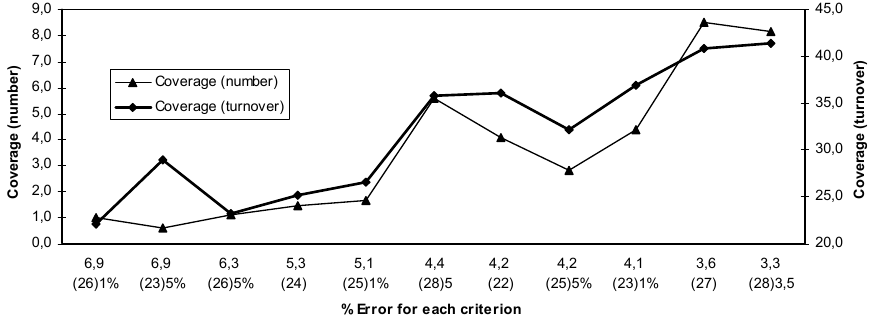
Figure 1 – Estimate errors and coverage using Ф 2 and option a), formula (2) – Level .